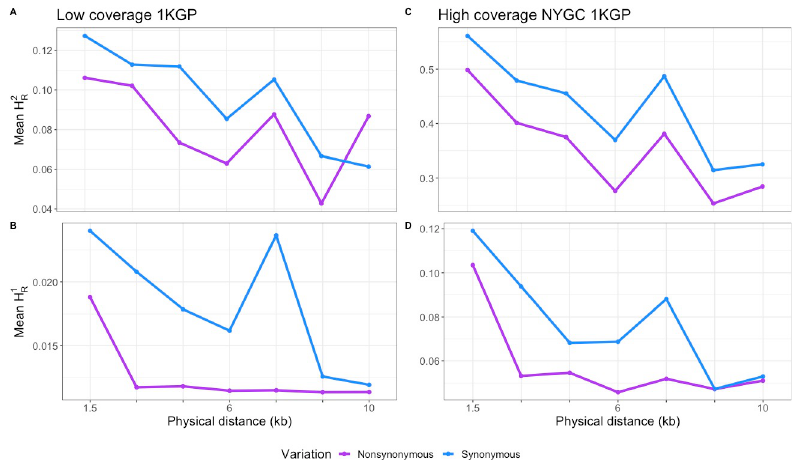
Fig 5. Distribution of mean H R(2) and H R(1) across empirical data sets with different coverages. (A, B) Low- coverage 1KGP data. (C, D) High-coverage NYGC 1KGP data. For both datasets, mean H R(2) and mean H R(1) between NS pairs of doubletons is on average lower than that of S pairs of variants.